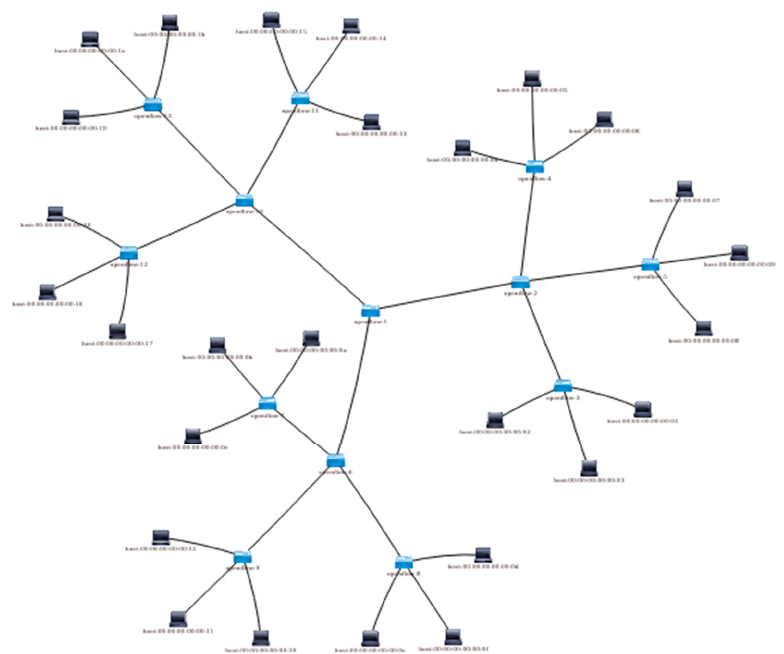
Electronics 2022 , 11 , 2715 Figure 22. Diagrammatically create custom tree network topology on ODL DLUX console.